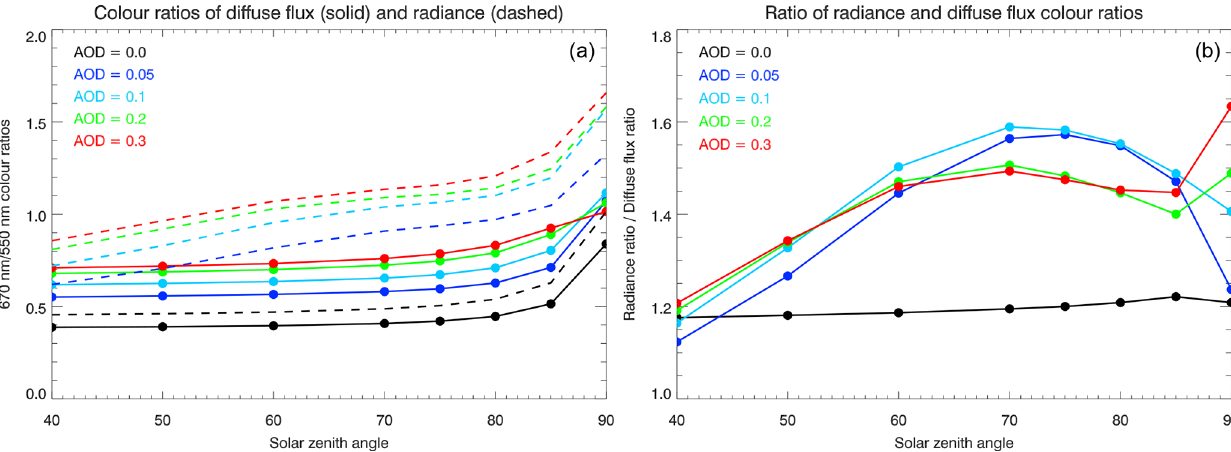
Figure 8. (a) SZA dependence of the 670nm / 550nm diffuse downward flux ratio (solid lines) and radiance ratio (dashed lines) for different AOD values. (b) SZA dependence of the ratio between the radiance and diffuse flux ratios shown in the left panel, i.e. the ratio of the dashed and solid lines. The following parameters apply to both the diffuse flux and the radiance simulations: TOC = 300DU, A S = 0 . 3, r med = 250nm, S = 1 . 5. The observer is located at the Earth’s surface. The viewing angles for the radiance simulations were VZA = 85 ◦ and SAA = 10 ◦